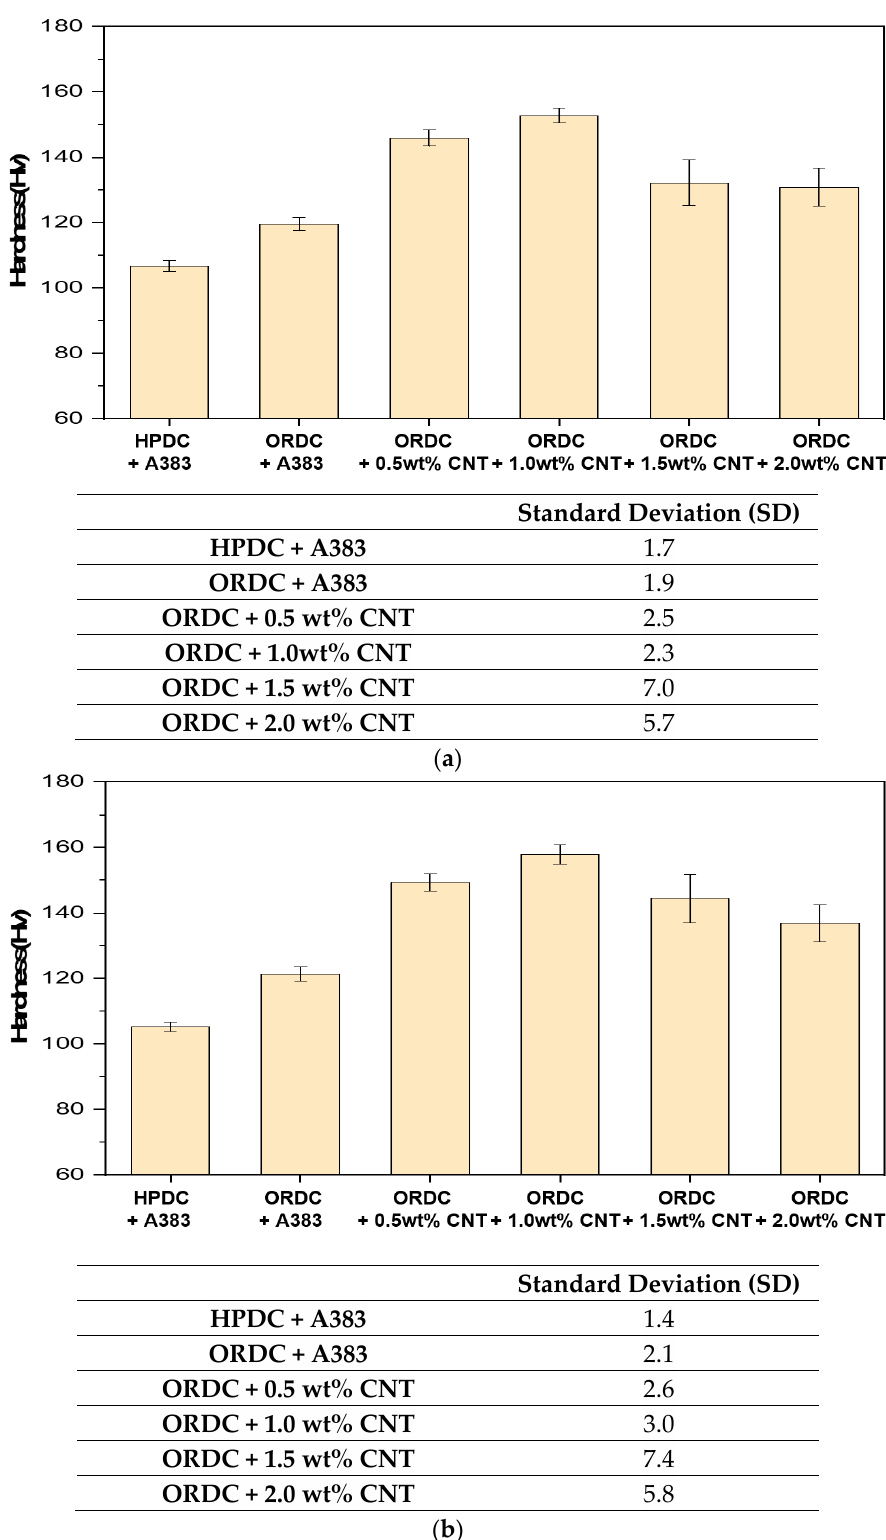
Figure 12. Vickers hardness of A383 alloy and 0.5–2.0 wt% CNT-added composites cast using ( a ) a single gate and ( b ) poly gate by using HPDC and ORDC.